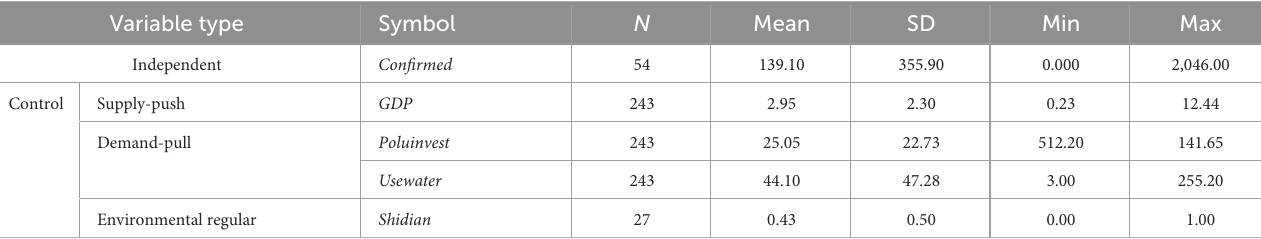
TABLE 2 Descriptive statistics of